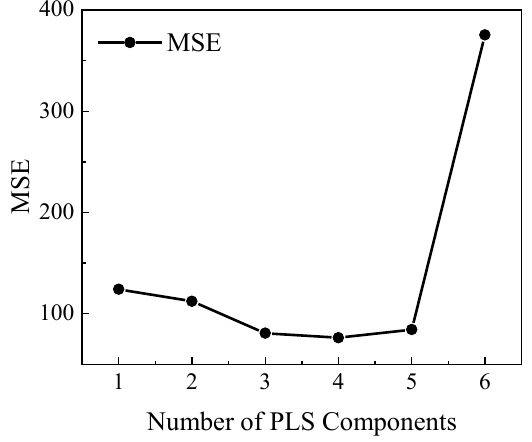
Figure 4. Variation of MSE with the number of PLS components.